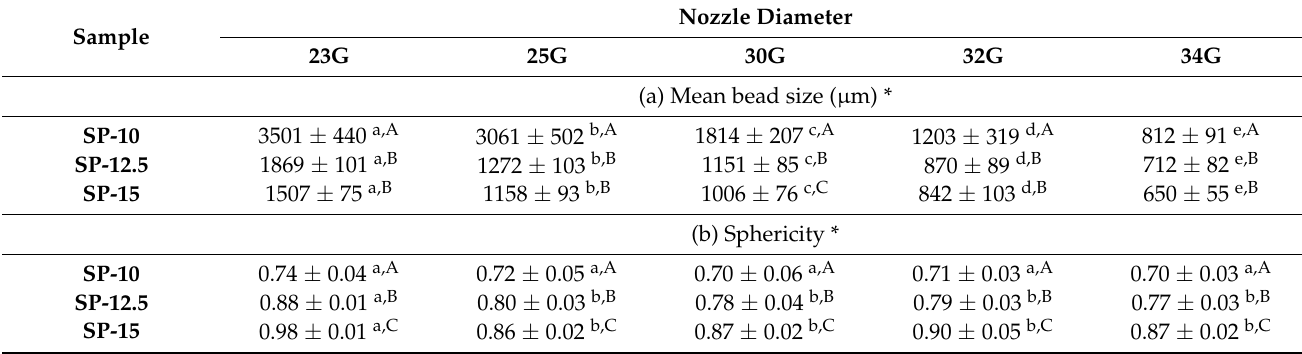
Sample Table 2. The mean (a) bead size and (b) sphericity of the 3D-printed starch beads. Nozzle Diameter Sample 25G 30G